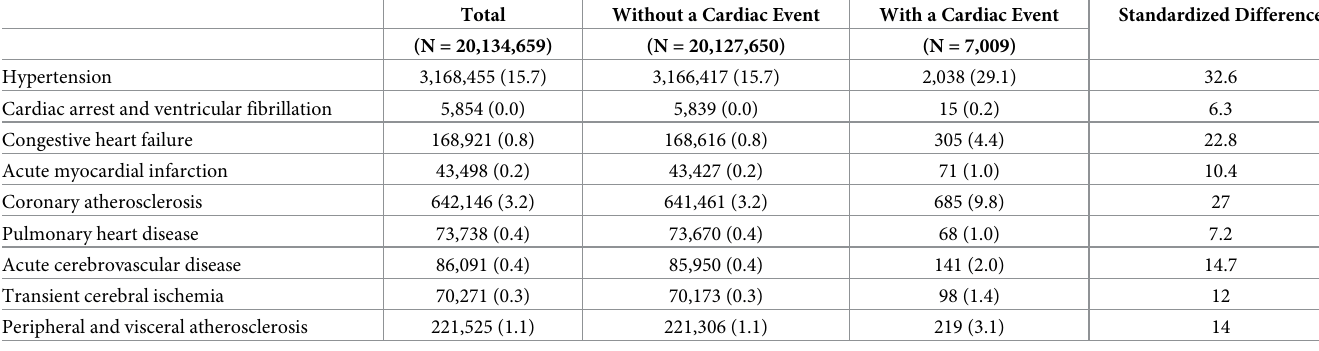
Table 3. Comorbid conditions of cohort by outcome.